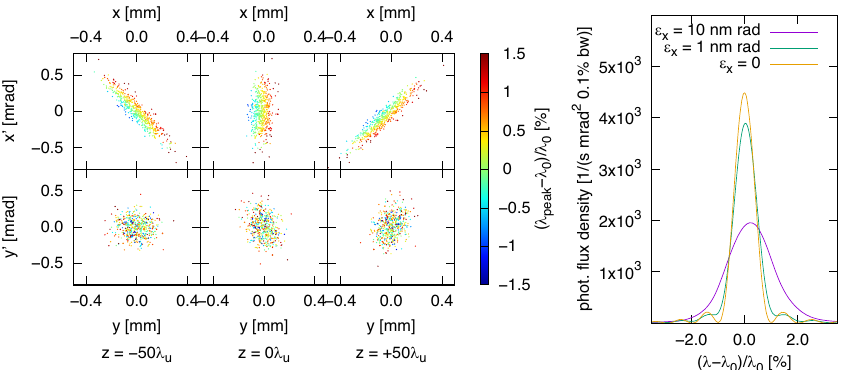
FIG. 11. Left: phase space distribution in x and y of a 120 MeVelectron bunch at the entrance, center and exit of the idealized cylindric TGU. The electron bunch parameters were chosen as β waist x ¼ 0 . 5 m, β y ¼ 0 . 7 m ¼ const and the geometric emittance ϵ ¼ ϵ ¼ 10 − 8 m rad. The color scale refers to the relative deviation of the peak energy of the radiation emitted by the respective x y particle with respect to that of the reference particle. Right: incoherently added radiation spectrum emitted by the particle bunch as a whole for different values of ϵ x;y , observed at infinite distance.